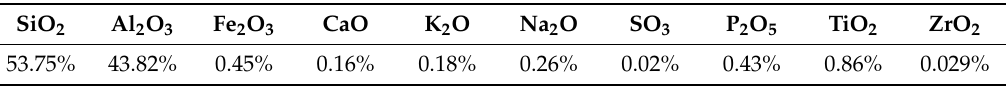
Table 1. Chemical composition (wt %) of metakaolin determined by X-ray Fluorescence (XRF).